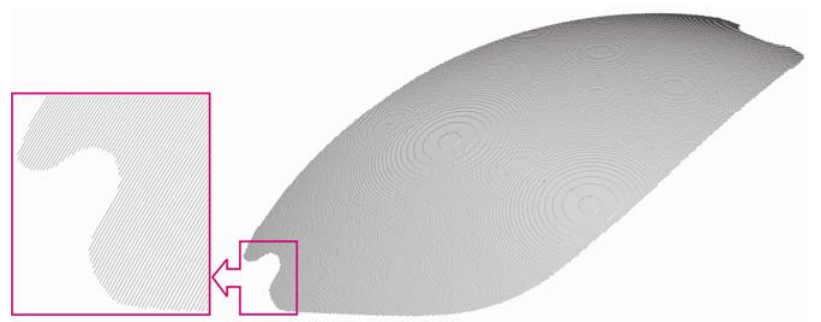
Figure 25. ( a ) Generated cross-sectional curves. ( b ) Surface